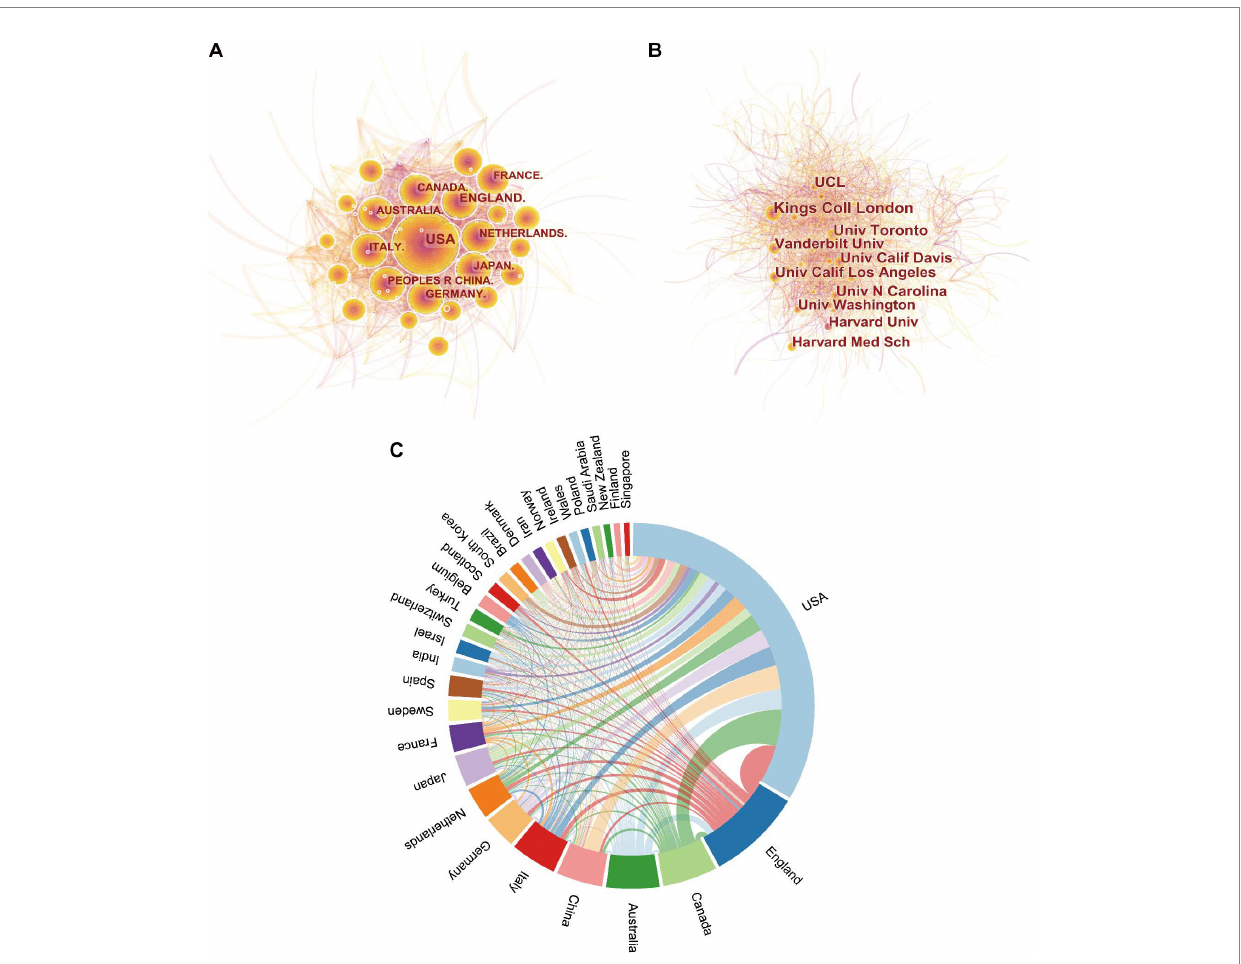
FIGURE 3 The distribution of countries and institutions. Map of countries (A) and institutions (B) contributed to publications related to ASD research. (C) Network diagram showing international collaborations involved in ASD research. The nodes represent the countries and institutions; the color depth and size of the circle are positively correlated to the number of posts. The thickness of the curved connecting lines represents the strength of collaboration in the countries and